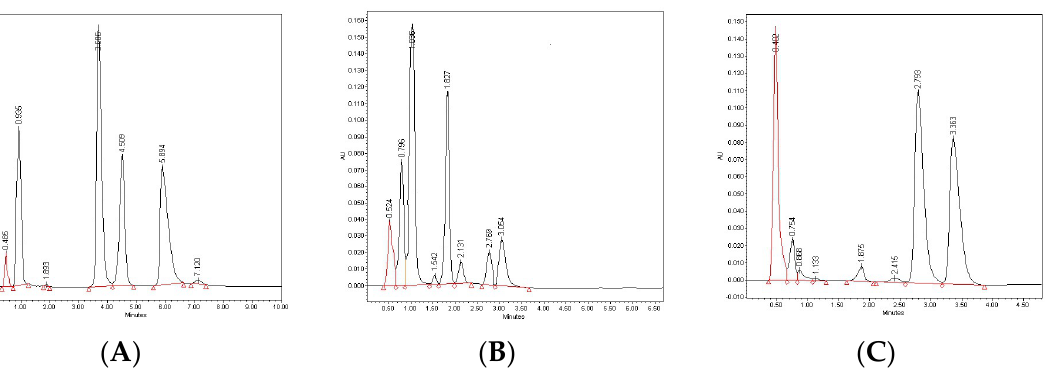
Figure 7 . Typical chromatograms of the stressed drugs: ( A ) diphenhydramine (DIPH) after stressing with temperature in 0.1 M HCl (DIPH = 5.894 min, D1 = 0.935 min, D2 = 1.893 min, D3 = 4.509 min and D4 = 7.120 min); ( B ) azelastine (AZE) after stressing with UV/VIS light at pH 10 (AZE = 3.054 min, A1 = 1.036 min, A2 = 1.542 min, A3 = 2.131 min and A4 = 2.769 min); ( C ) bepotastine (BEPO)